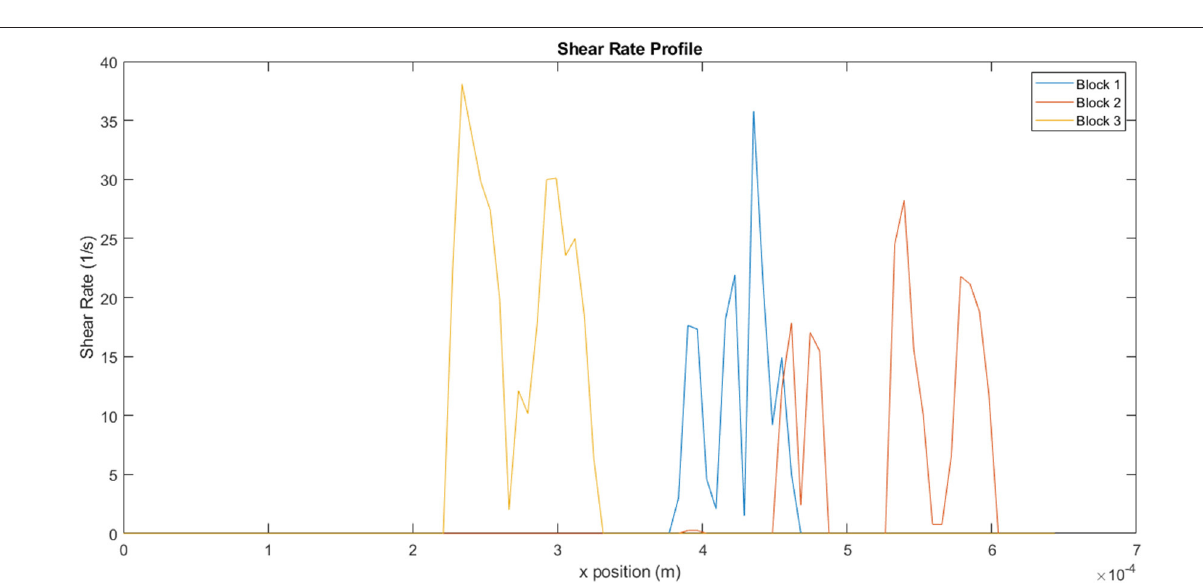
FIGURE 13 | Variation in shear rate across the channels for the different myocardial flow